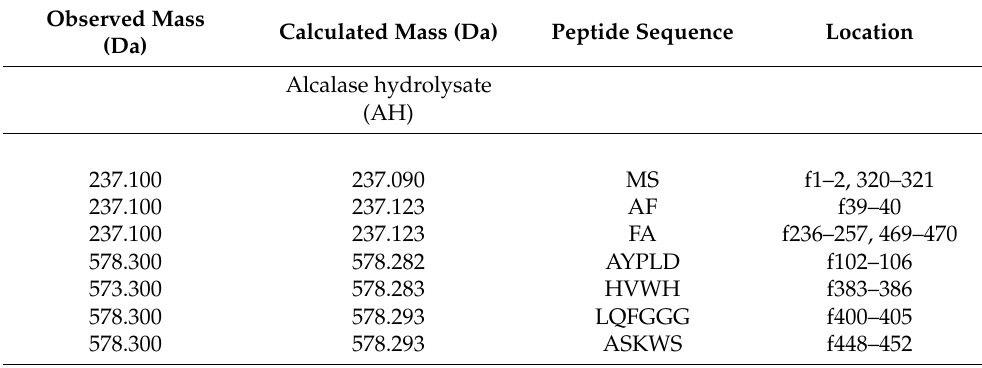
Table 2. Amino acid sequences of peptides identified in the enzymatic hydrolysates of eggplant leaf protein